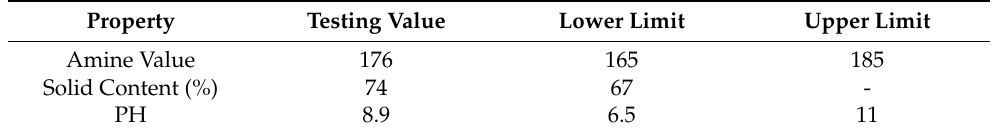
Table 4. Properties of